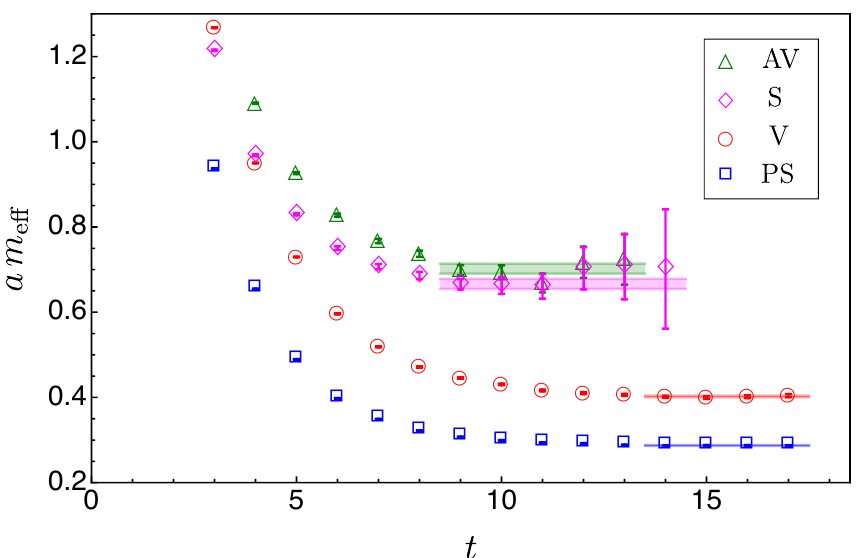
Figure 20. Example of e(cid:11)ective mass plots of low-lying spin-0 and spin-1 mesons. The data is taken from the DB3M7 ensemble (see list in table 1), which is characterised by the lattice parameters (cid:12) = 7 : 2 and am 0 = (cid:0) 0 : 794. The individual (cid:12)ts that yield the masses of the PS, V, S and AV states are restricted to include only the plateau regions, which are highlighted by the shaded bands. The width of each band represents for the statistical uncertainty.